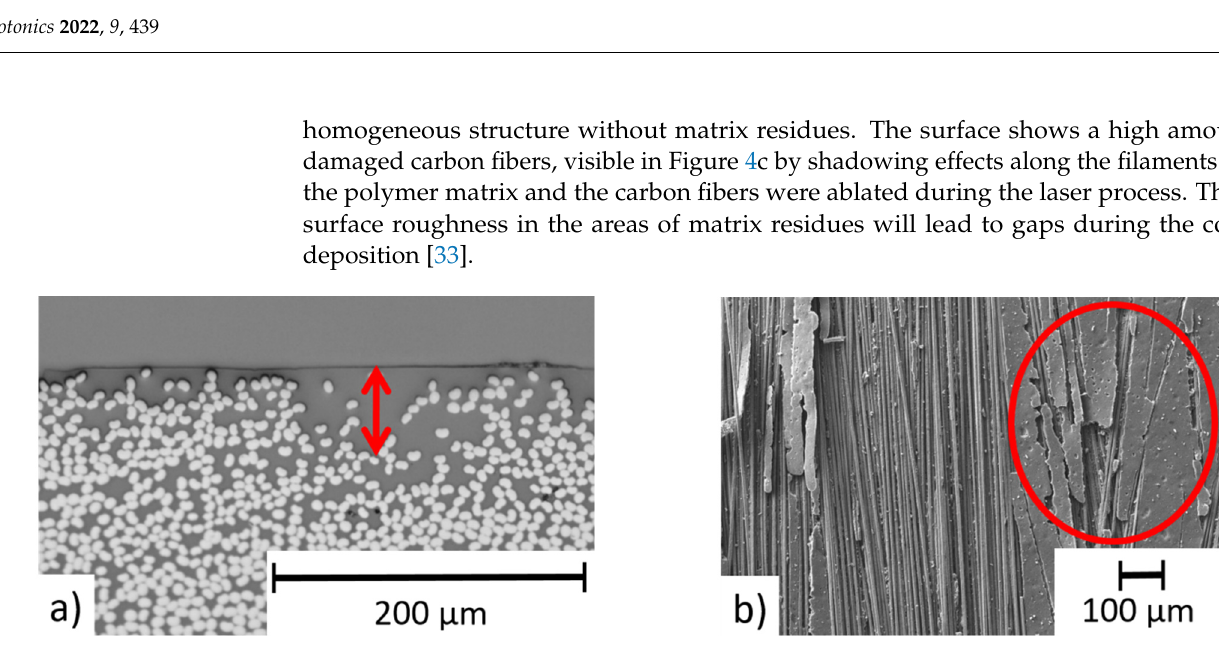
Figure 3. ( a ) Cross-section of CFRP with a highlighted area of a higher amount of epoxy resin; ( b ) heterogeneous ablation result due to heterogeneous amount of epoxy resin covering the carbon fibers, circle shows area of insufficient ablation.